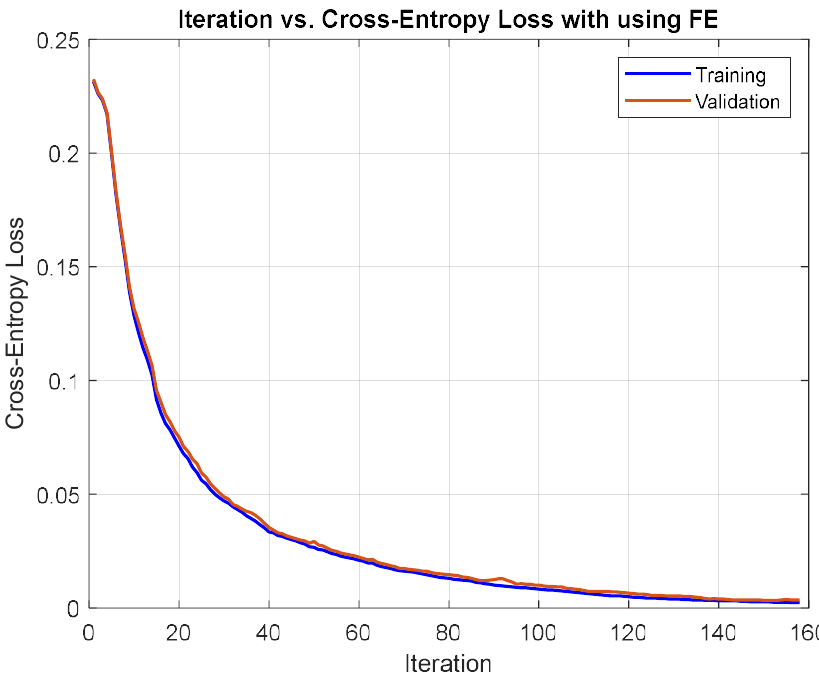
Figure 6. Iteration vs. cross-entropy loss for features extraction of noisy signals with length 6400 and three hidden layers with (30, 25, 20) nodes. Note that increased layers and nodes lead to an accuracy of 98 with fewer iterations of 158.